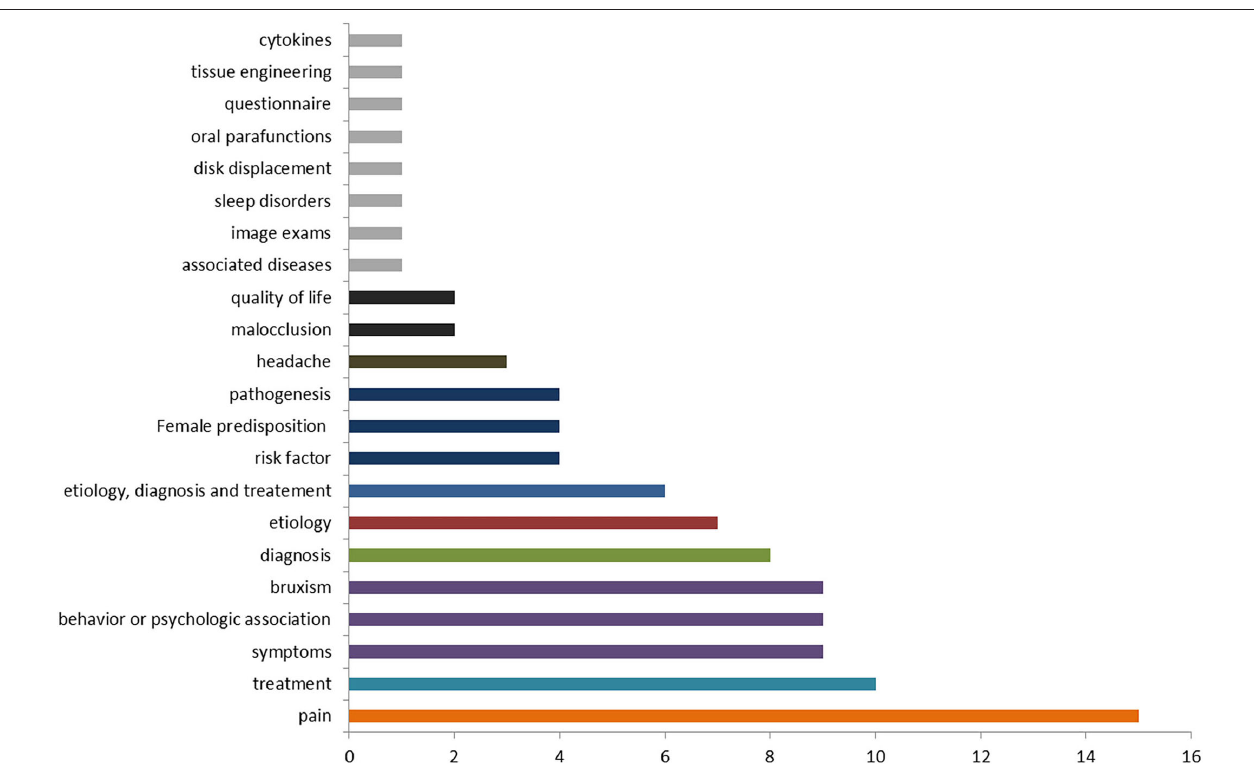
Frontiers in Oral Health |